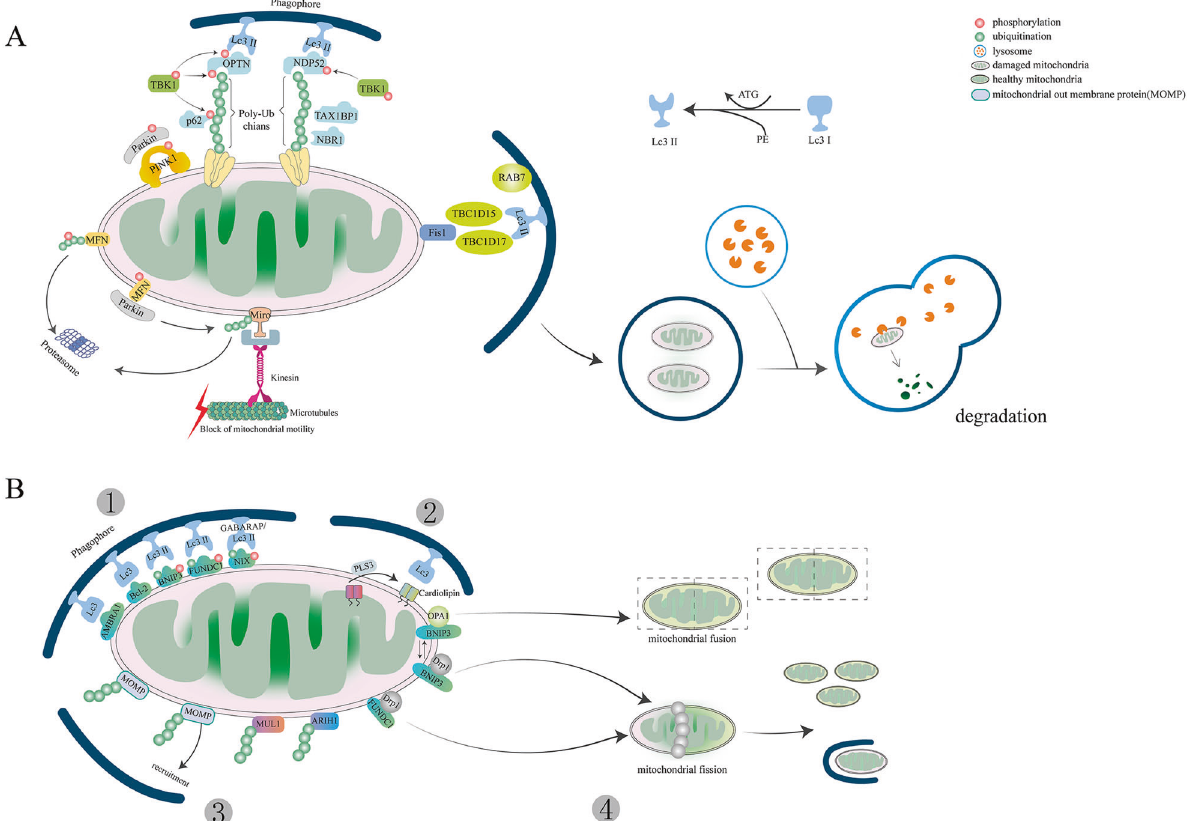
Fig. 2 Pathways of mitophagy. A Parkin-dependent mitophagy: While mitochondria became damaged (pink), PINK1 is accumulated on the OMM, promoting Parkin recruitment to ubiquitinate several outer membrane components. Phosphorylated Poly-Ub chains on mitochondrial proteins modify other proteins and serve as an ‘ eat me ’ signal for the autophagic machinery. TBK1 interacts with Ub chains by phosphorylating OPTN, which promotes mitochondrial clearance. The PINK1-Parkin pathway modulates mitochondrial dynamics and inhibits damaged mitochondria entering the mitochondrial network by targeting Mfn and Miro for proteasomal degradation. B Other pathways of Parkin-independent mitophagy: (1) Bnip3, Bnip3L/Nix, FUNDC1 and other receptor-mediated mitophagy; (2) Lipid-mediated mitophagy; (3) E3 ubiquitin ligases or ubiquitin-mediated mitophagy; (4) Mitophagy and mitochondrial dynamics. Mitophagy receptors such as BNIP3 and FUNDC1 promote the fi ssion of damaged organelles through the disassembly and release of OPA1 and the recruitment of